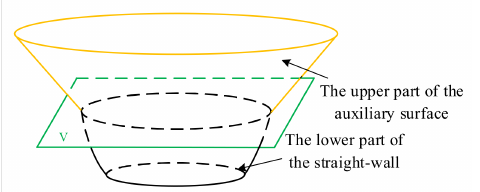
Figure 10. The second-stage forming-model generation.